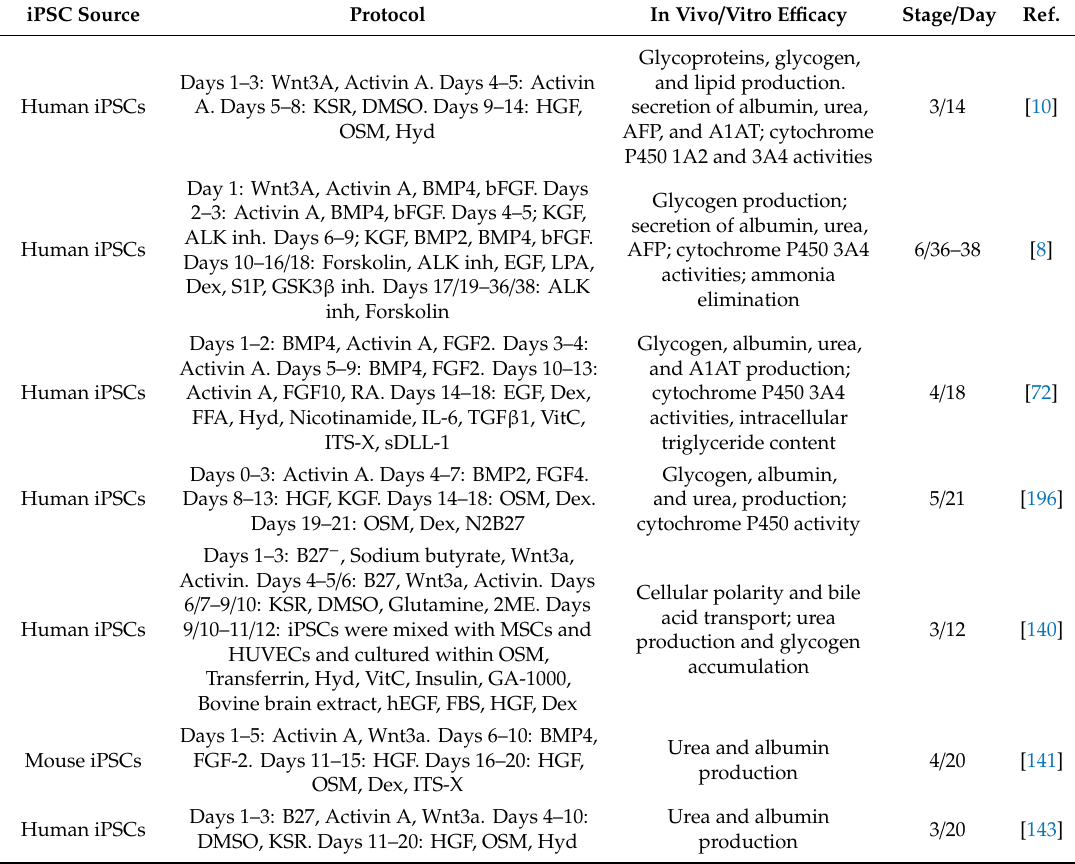
Table 3. Overview of protocols used for di ff erentiation of hepatocytes from various sources of iPSCs. iPSC Source Protocol In Vivo / Vitro E ffi cacy Stage / Day Ref.